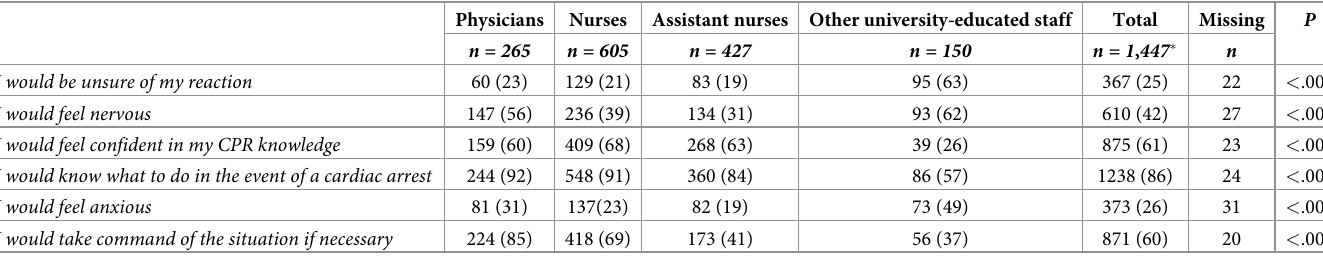
only applicable to physicians, nurses, and assistant nurses. Table 3 shows attitudes regarding performing CPR in connection to the latest real-life cardiac arrest situation. During the latest cardiac arrest situation, 30% of HCPs were worried about making mis- takes or causing complications, but few were worried about contracting an illness (5%) or felt discomfort at initiating CPR (11%). After the latest cardiac arrest situation, 57% of HCPs reported feeling stressed, 27% reported feeling anxious, 52% reported feeling calm, 49% reported feeling pleased, and 11% reported feeling like a failure. Significant differences Table 2. Attitudes towards being required to perform CPR in the event of a cardiac arrest